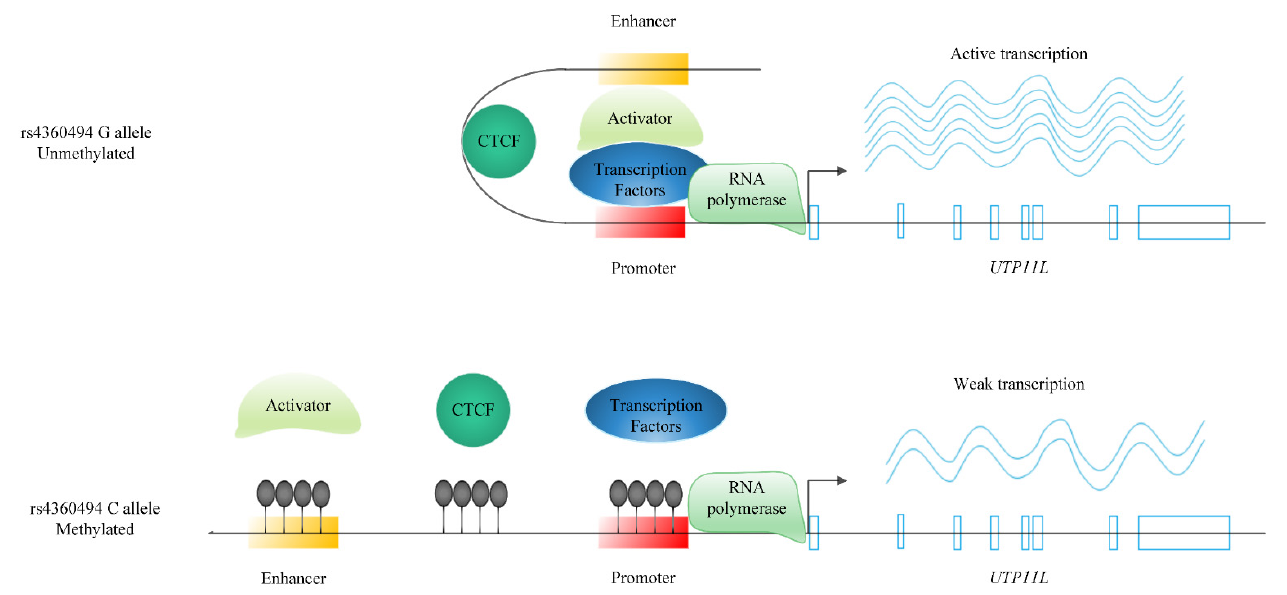
Figure 7. Potential regulatory mechanism for UTP11L through which a BP-associated variant controls BP-associated gene expression. SNP rs4360494 is positively correlated with the expression of UTP11L . At the same time, this SNP is inversely associated with the methylation level of three sites at the promoter and the early sequence of this gene as well as the upstream enhancer and an active CTCF-binding site. The overall hypothesis is that rs4360494 regulates gene expression by controlling the methylation of the promoter and the enhancer as well as the CTCF-binding site. CTCF increases the expression of UTP11L in the presence of the rs4360494 G allele by involving enhancer activity through DNA remodelling, and disruption of CTCF binding due to the methylated DNA in the presence of the rs4360494 C allele decreases the expression of the UTP11L gene.